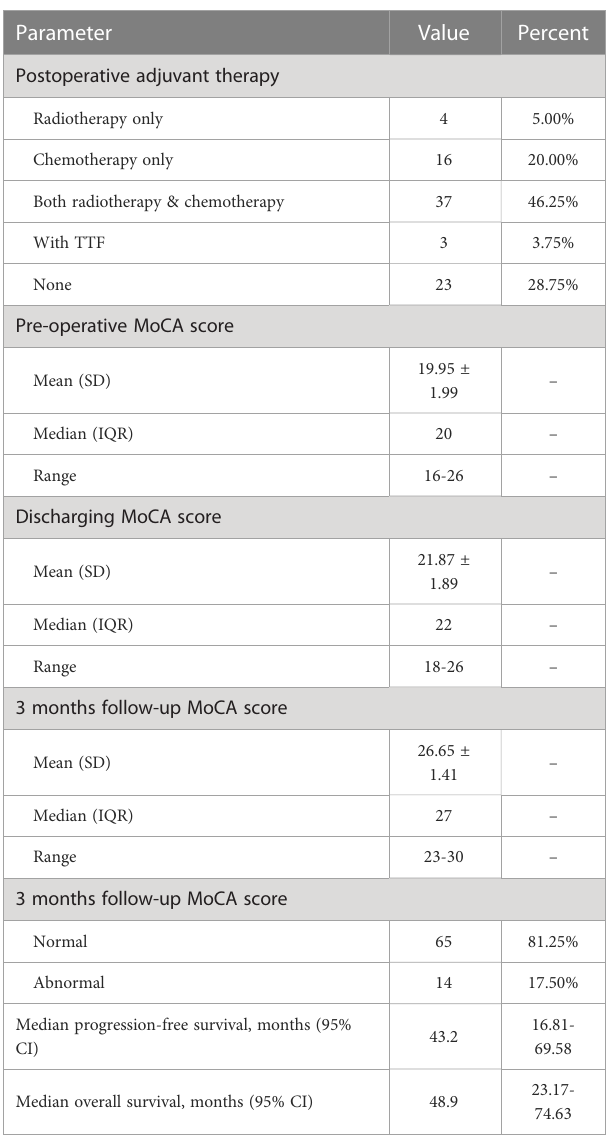
TABLE 4 Treatments and neurological de fi cit and general performance